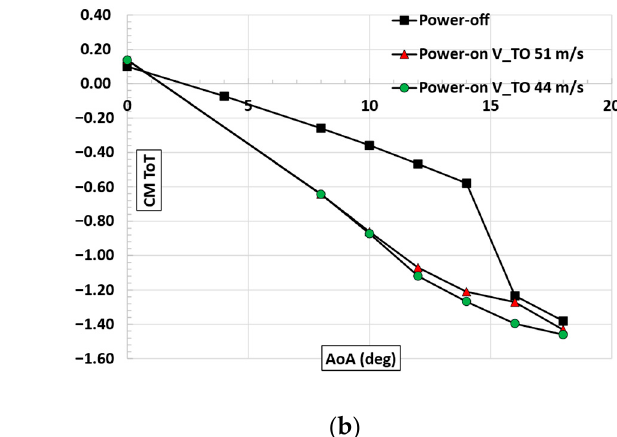
Figure 25. Drag and pitching moment curves, take-off condition V TO = 44 m/s and V TO = 51 m/s, Re = 5.7 × 10 6 , J TIP = 0.78, rpm TIP = 1600, J DEP = 0.89, rpm DEP = 2000. ( a ) Drag polar (drag expressed in counts). ( b ) Pitching moment coefficient w.r.t. CG pos. (31% mac). Table 17. Numerical results for take-off power-on condition, untrimmed maximum lift coefficient, moment coefficient calculated w.r.t. CG pos. (31% mac), V TO = 44 m/s and V TO = 51 m/s, Re = 5.7 × 10 6 , J TIP = 0.78, rpm TIP = 1600, J DEP = 0.89, rpm DEP = 2000.